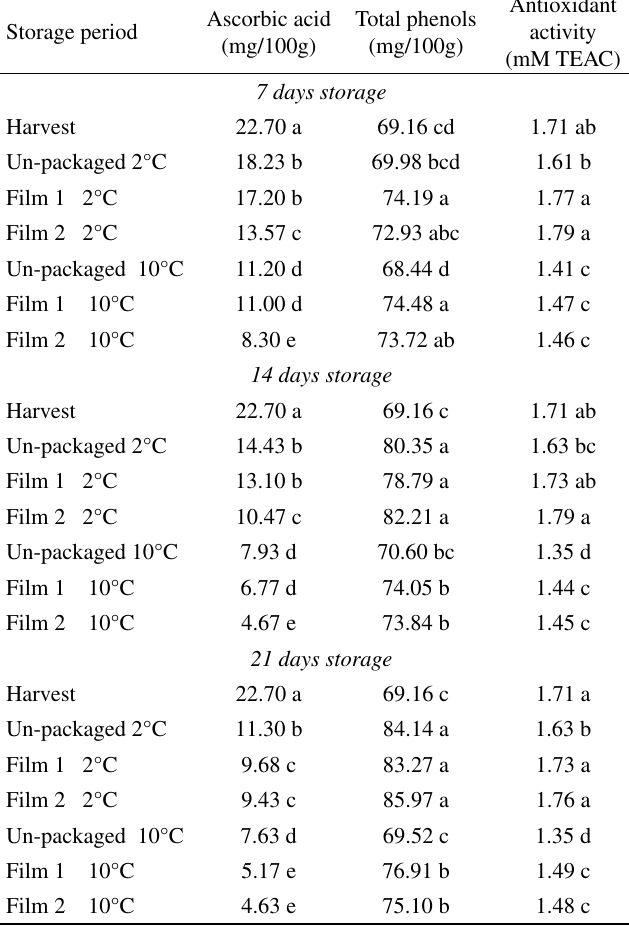
Table 2 - Influence of film packaging (Film 1, Omnifilm PVC film; Film 2, Bolphane BX polyolefinic film) and storage condi- tions on ascorbic acid, total phenols and antioxidant activity